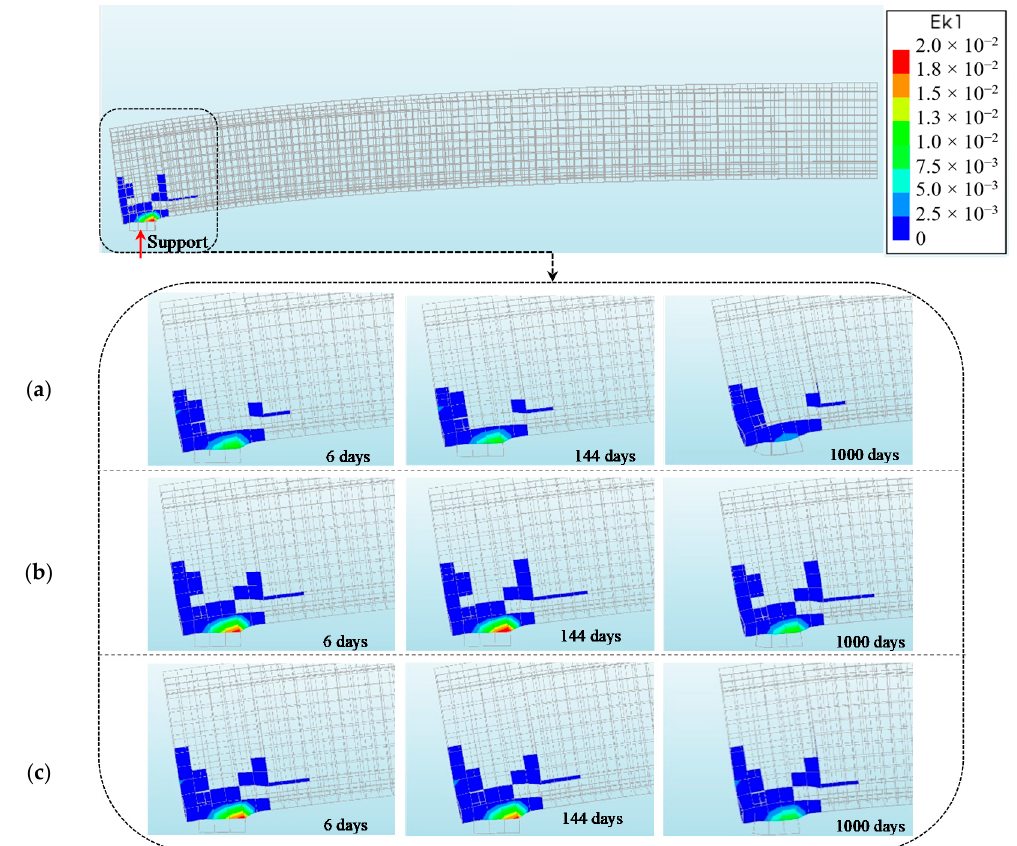
Figure 14. Distribution of crack strain of the medium-span PSC box girder at 6th, 144th, and 1000th days. ( a ) Cracking only ; ( b ) C&US + Cracking ; ( c ) C&US + NUS + Cracking.